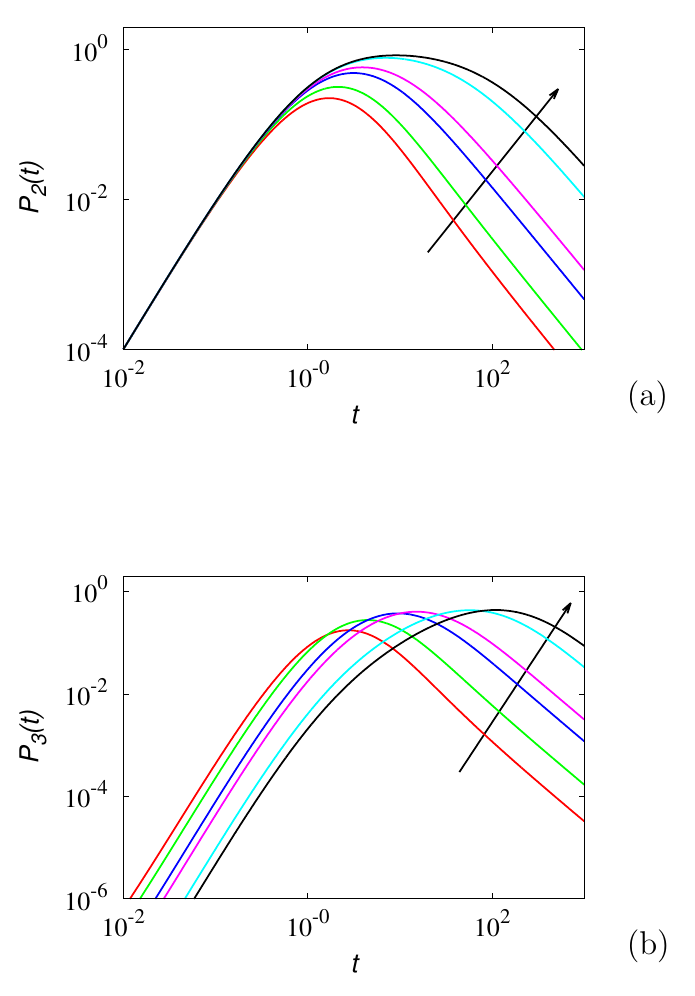
Figure 4. Counting probabilities P 2 ( t ) ( a ) and P 3 ( t ) ( b ) for the generalized counting process described in the main text at ξ = 1.5 as a function of the delay τ c . The arrows indicate increasing values of τ c =